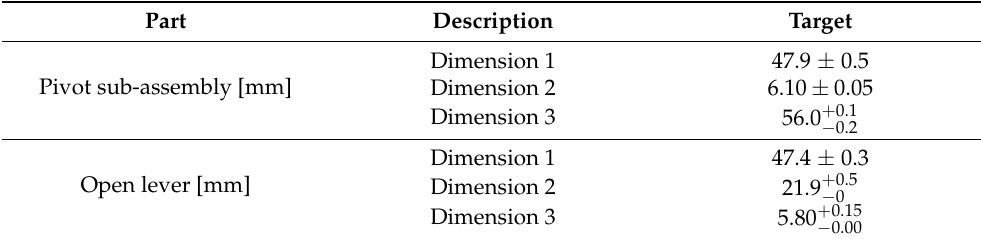
Figure 2. The shape of open lever. ( a ) Overview of the open lever. ( b ) Side view of the open lever and location of dimension 3. ( c ) Bottom view of the open lever and location of dimension 1 and 2. Table 3. Key dimensions for pivot sub-assembly and open lever.